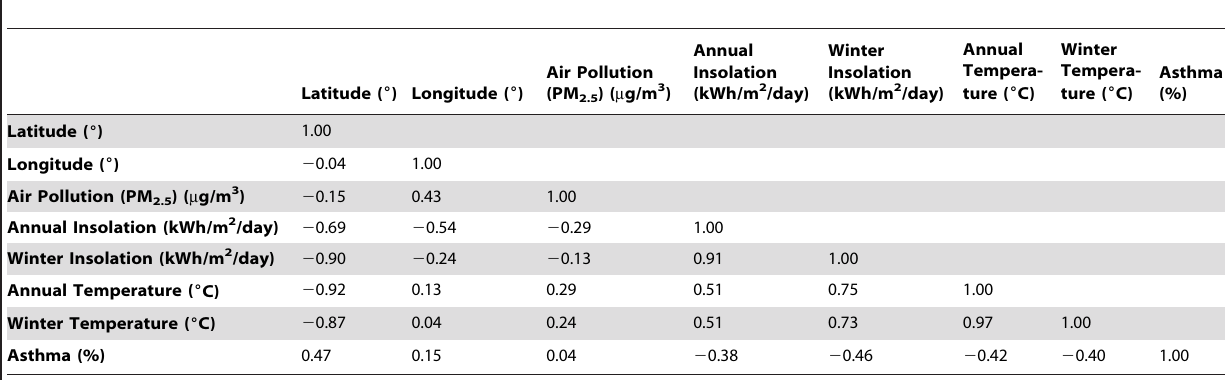
Table 3. Correlation matrix for asthma prevalence in US adult population, latitude, longitude, air pollution (PM 2.5 ), annual insolation, winter insolation, annual air temperature, and winter air temperature.